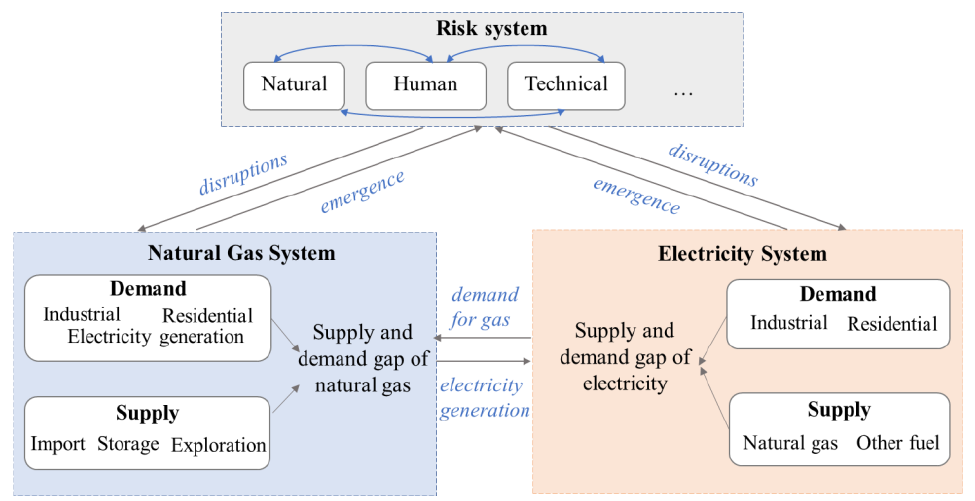
Figure 1. Mechanism of risk evolution in a coupled natural gas – electricity